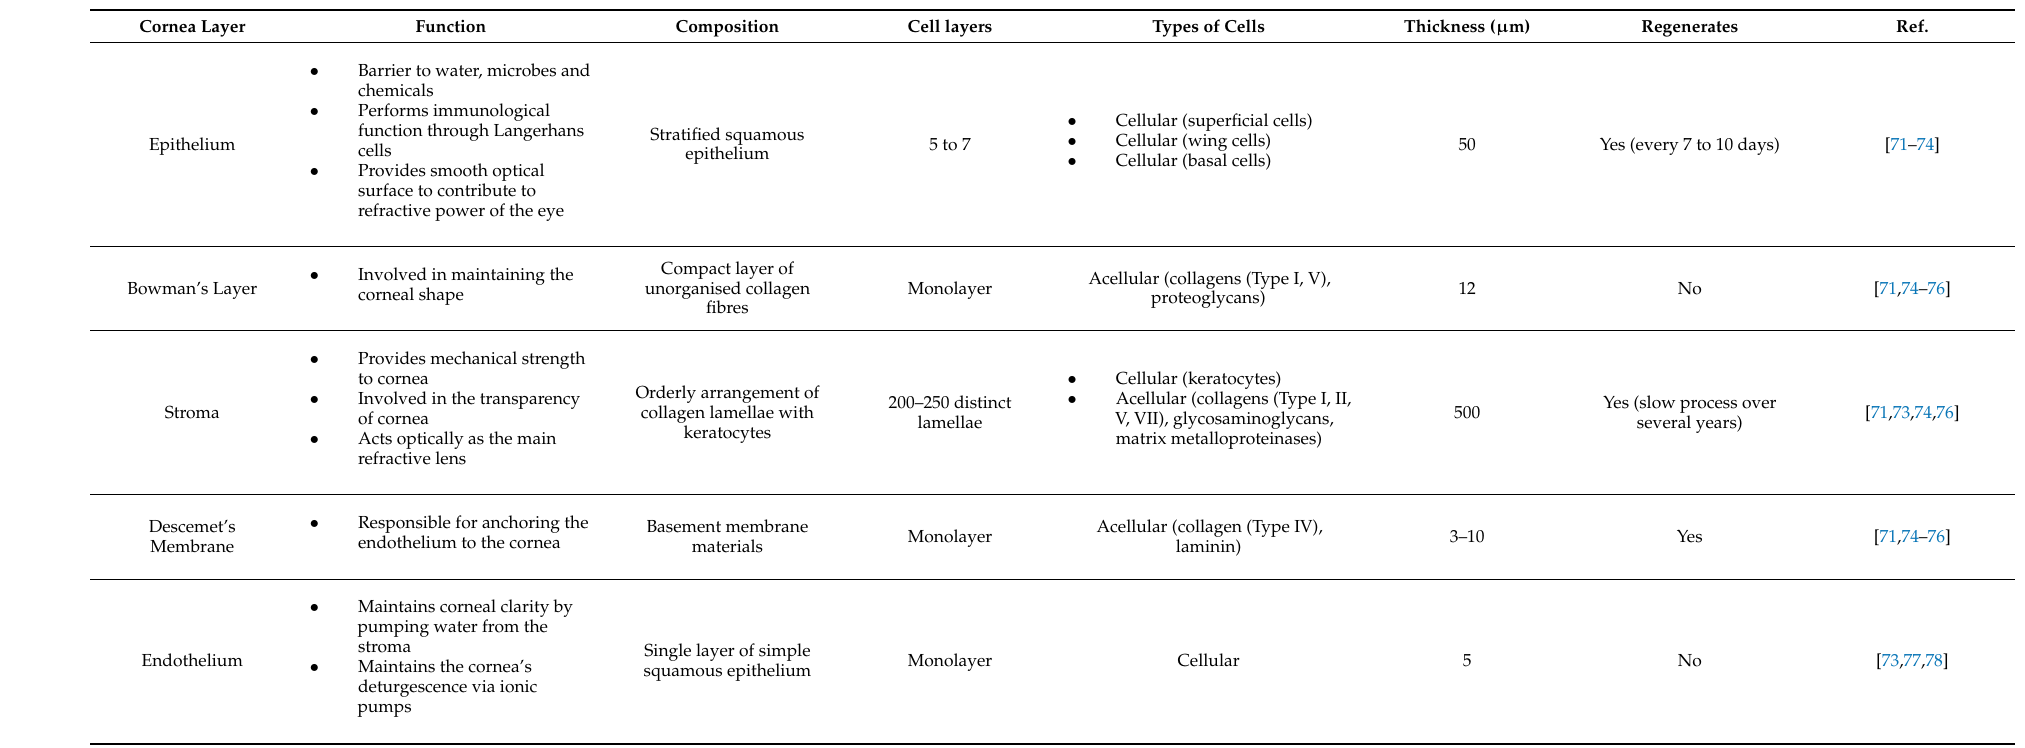
Table 3. The hierarchical structure of the